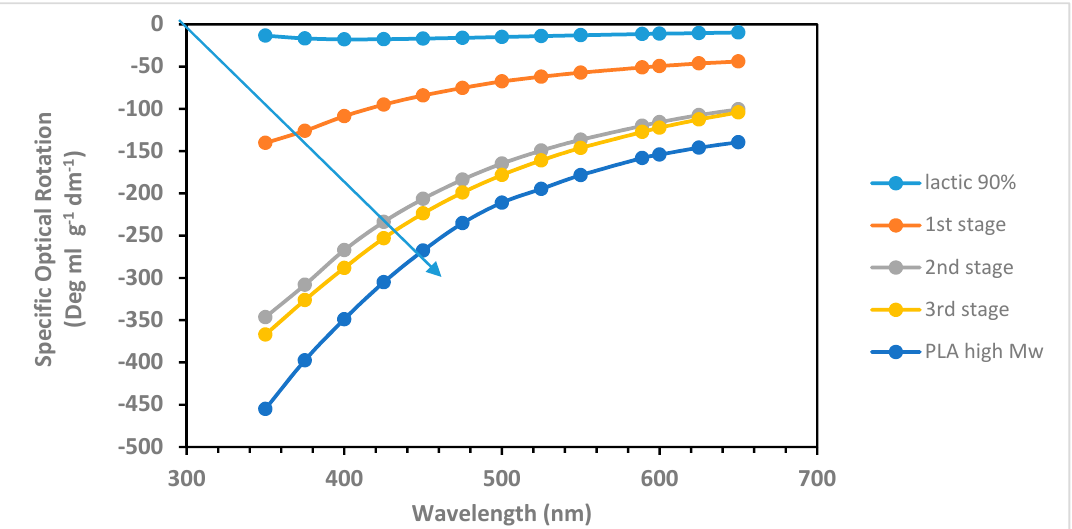
Figure 1. Optical rotatory dispersion (ORD) of poly(lactic) acid oligomers (PLAO) at different degrees of oligomerization. The arrow shows the growth in optical activity as function of the molecular weight increase, starting from the ORD curve of 90% l -(+)-lactic acid (neat, light blue dots at the top of the figure) to a high molecular weight poly( L -lactic acid) (PLLA) dissolved in CHCl 3 (1.50 g/100 mL; dark blue dots at the bottom of the figure). The ORD curves of the PLAO oligomers were recorded in acetone solvent, with the exception of the last curve in yellow dots, which required the use of CHCl 3 solvent (in all cases, 1.50 g in 100 mL).